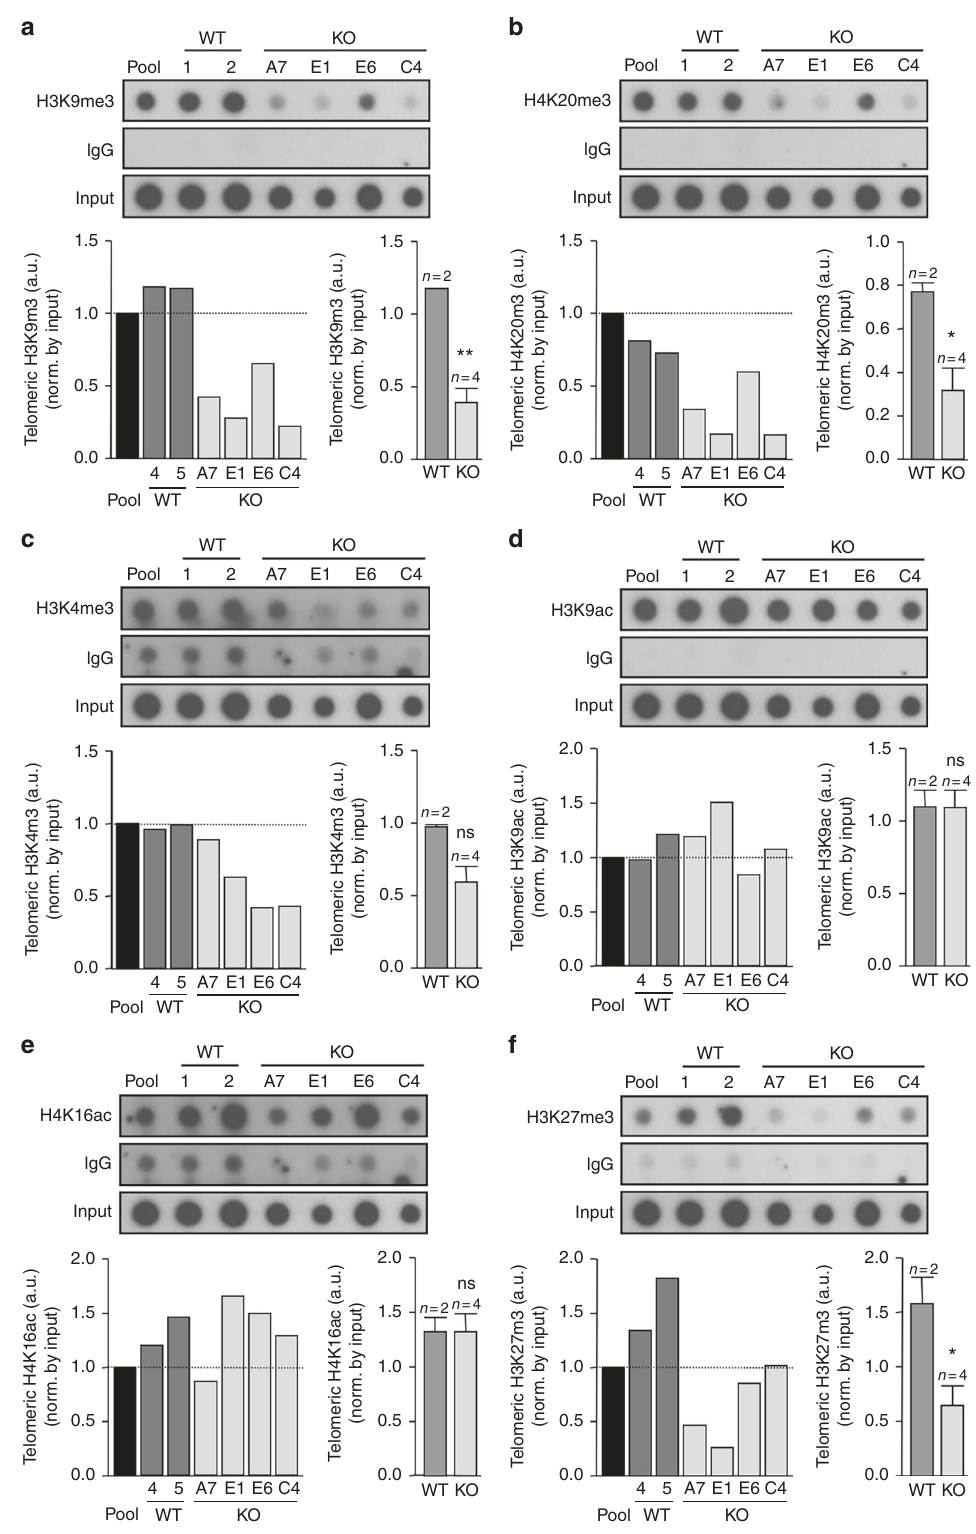
Fig. 3 TERRAs are essential for the assembly of heterochromatic histone marks at the telomere, including H3K27me3. a ChIP-dot-blot of the H3K9m3, b H4K20m3, c H3K4m3, d H3K9ac, e H4K16ac, and f H3K27me3 histone marks for the U2OS cells WT pool, WT clones (#1 and 2), and from the 20q- TERRA KO clones (#A7, E1, E6, and C4), hybridized with a southern probe against the telomeric repeat. ChIP-dot-blot for IgG was used as a control. IgG ChIP-dot-blot shared by different antibodies shows different exposure times according to the best exposure time required for each antibody. DNA input signal is also shown. Below the ChIP-dot-blot for each mark is shown the quanti fi cation of the immunoprecipitated telomeric repeats normalized by the input for each individual sample (left graph) and for all WT clones vs. the 20q-TERRA KO clones (right graph) (mean values ± s.e.m., n = independent clone). Student ’ s t -test was used for the statistical analysis (* p < 0.05, ** p < 0.01, and *** p <